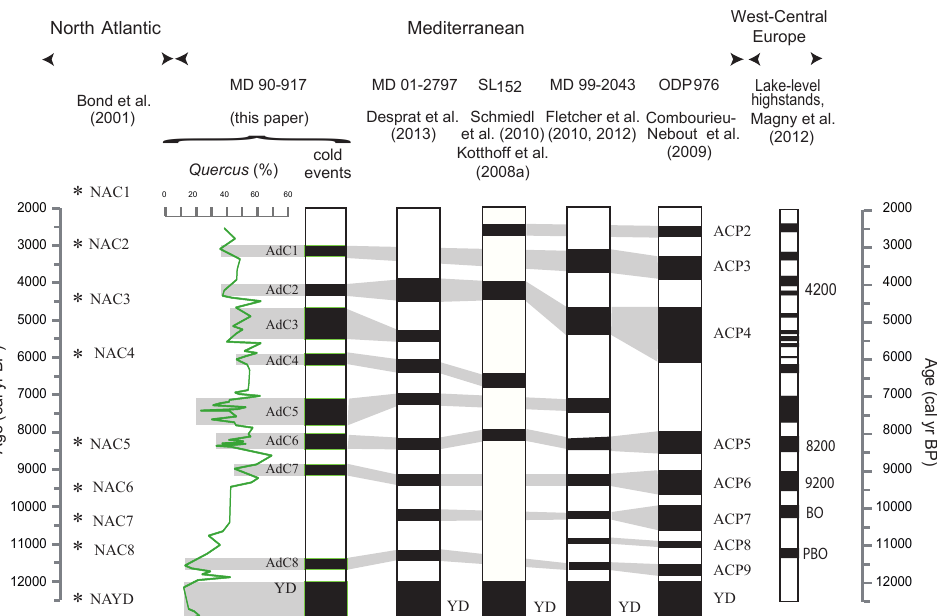
Fig. 8. Comparison of millennial cold events recorded in MD 90-917 with the cold events recorded from vegetation changes in other Mediterranean marine cores (Kotthoff et al., 2008a; Schmiedl et al, 2010; Fletcher et al., 2010, 2012; Combourieu-Nebout et al., 2009; Desprat et al., 2013). On the left are the North Atlantic Bond events (Bond et al., 2001) and, on the right, the periods of high lake levels recorded in the southern Alps (Magny et al.,